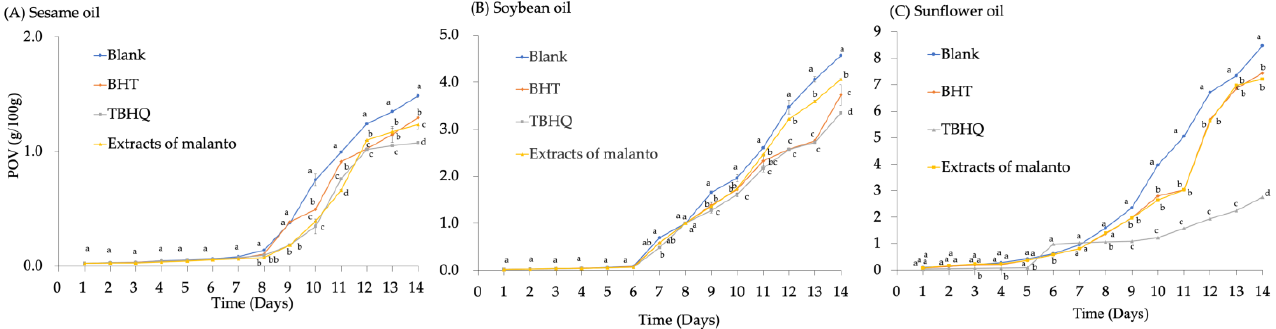
value of ( A ) Sesame oil, ( B ) Soybean oil, and ( C ) Sunflower oil. Different lowercase letters in the figure represent significant differences ( p < 0.05) .